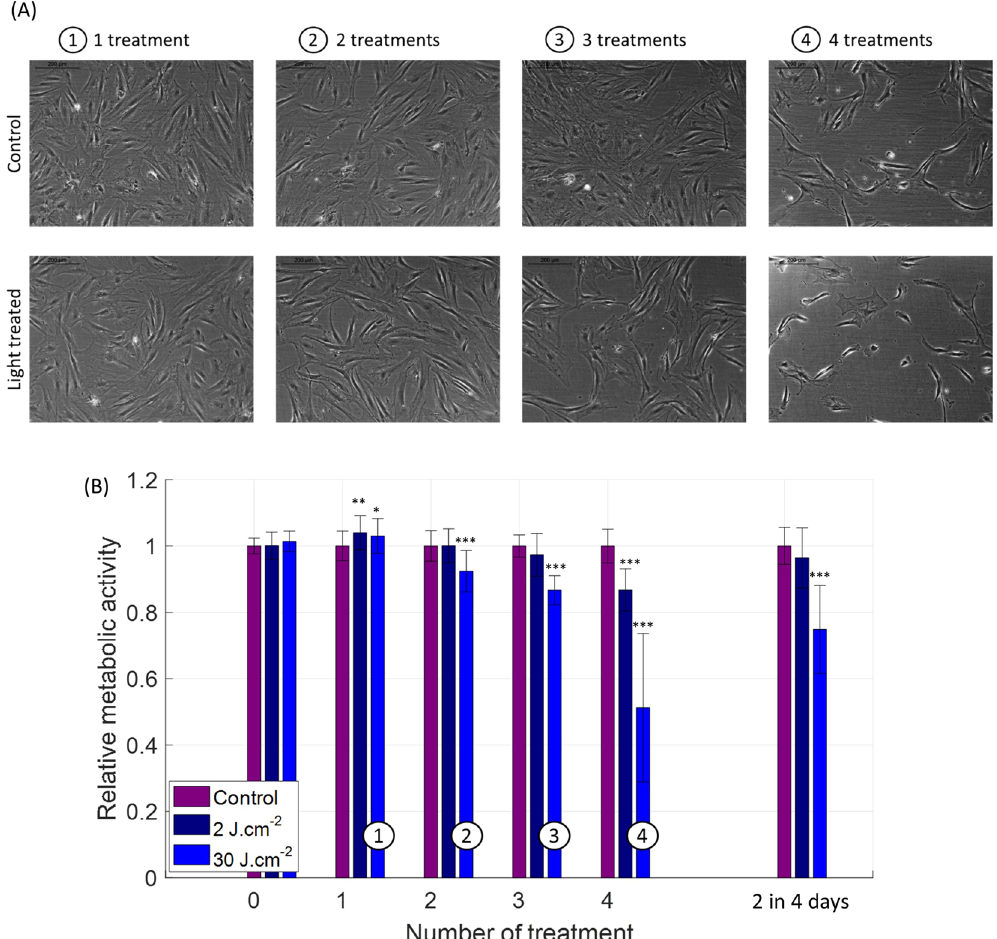
Figure 5. Response of human dermal fibroblasts to variable number of treatments with blue light (450 nm) occurring on consecutive days. ( A ) Phase-contrast images of human reticular fibroblasts 24 h after the last treatment, when 1, 2, 3 or 4 daily treatments (30 J.cm − 2 ) were performed (lower line), together with the images of the control group (upper line). ( B ) Relative metabolic activity of human papillary and reticular fibroblasts (merged) after light treatment for 2 radiant exposures of 450 nm light (at a fixed 50 mW.cm − 2 irradiance) and with variable number of treatments occurring on consecutive days. An irradiance of 50 mW.cm − 2 was used. Statistical analysis was evaluated using student t-tests between the control group and treated group (N = 2, 2 lineages and 3 replicates), with following thresholds * p < 0.05, ** p < 0.01, *** p < 0.001. The control group has an average relative metabolic activity of 1. The significance of the interaction between the radiant exposure and the number of iterative treatment was much lower than